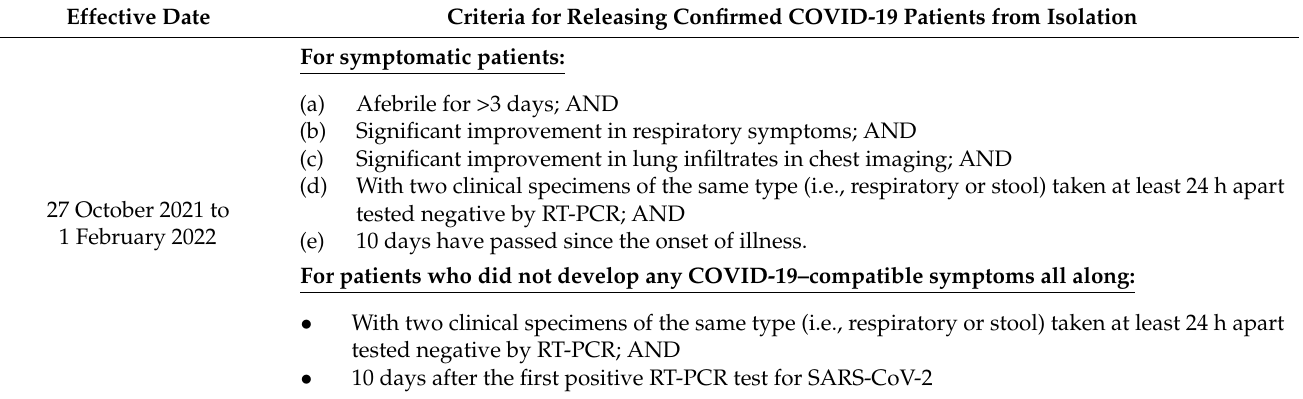
Table 1. Evolution of discharge criteria for laboratory-confirmed COVID-19 patients in Hong Kong. Criteria for Releasing Confirmed COVID-19 Patients from